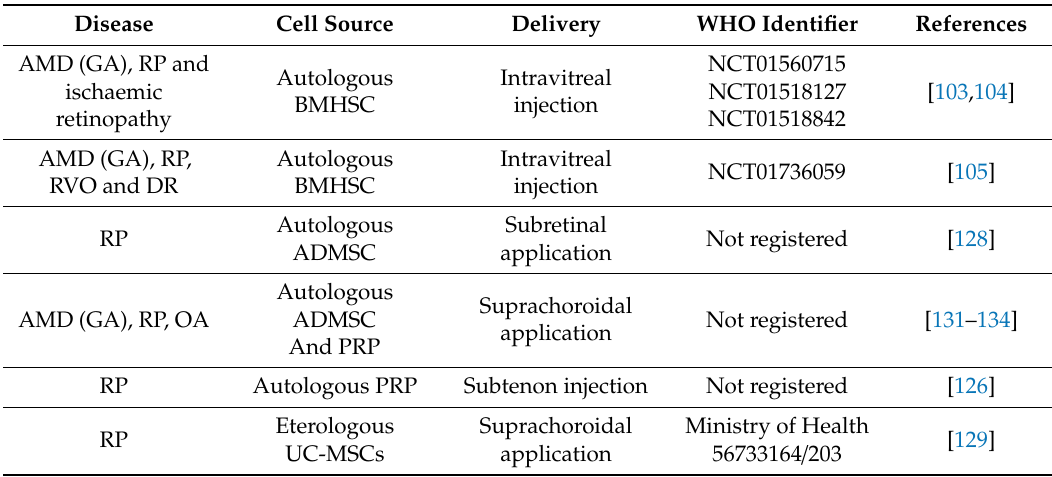
Table 1. Main clinical studies exploiting MSC for therapeutic purposes in